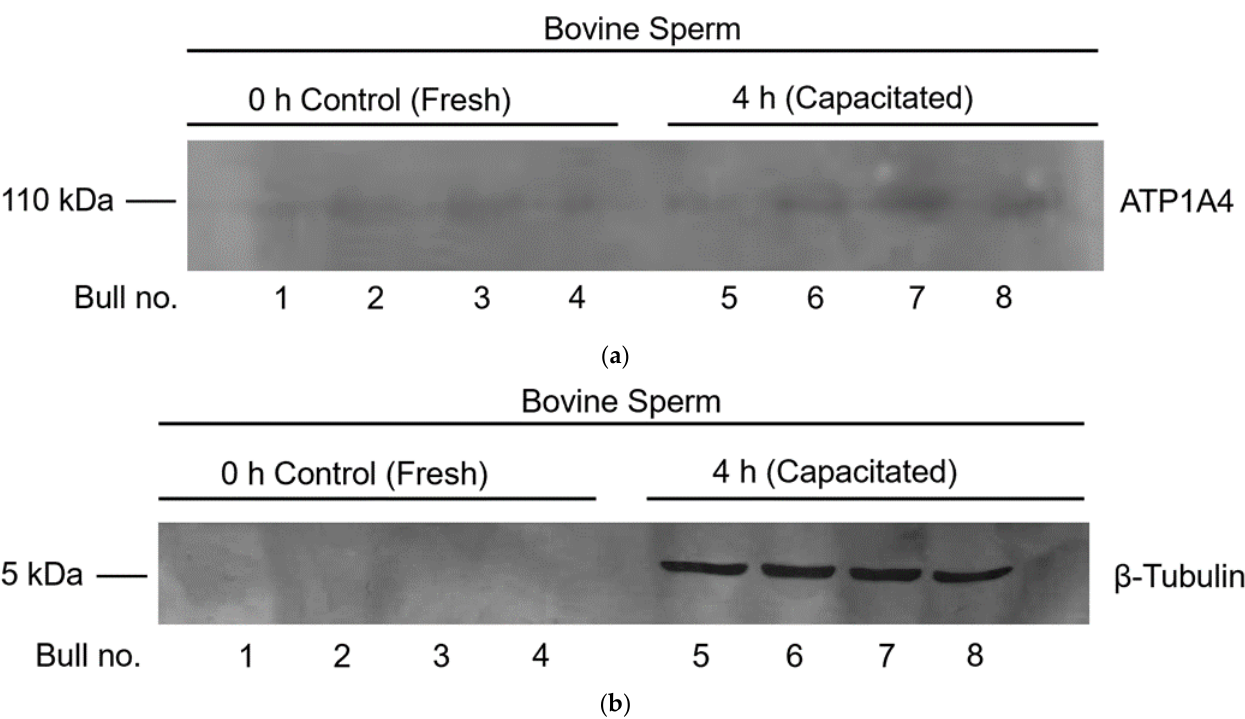
Figure 5. Co-immunoprecipitation data demonstrating interactions of tACE and ATP1A4 ( a ) and tACE and β -tubulin ( b ) in fresh and capacitated bovine sperm. Protein extracts from fresh and capacitated sperm were immunoprecipitated using anti-tACE antibody and immunodetected with anti-ATP1A4 ( a ) or anti- β -tubulin ( b ) antibody. Original unedited blots used in this figure were provided in Figure S3.